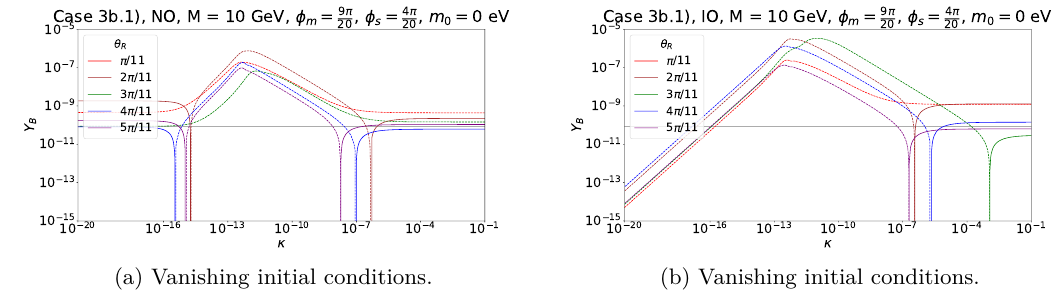
Figure 26 . Case 3 b.1) Y B as function of the splitting κ for a Majorana mass M = 10 GeV. Light neutrino masses follow strong NO (left plot) and strong IO (right plot), respectively. For each of these plots, different values of θ have been studied. The group theory parameters n , m and s are R fixed to n = 20 , m = 9 and s = 4 . Both negative (dashed lines) as well as positive (continuous lines) values of the BAU are represented. The grey line indicates the observed value of the BAU, Y B ≈ 8 . 6 · 10 − 11